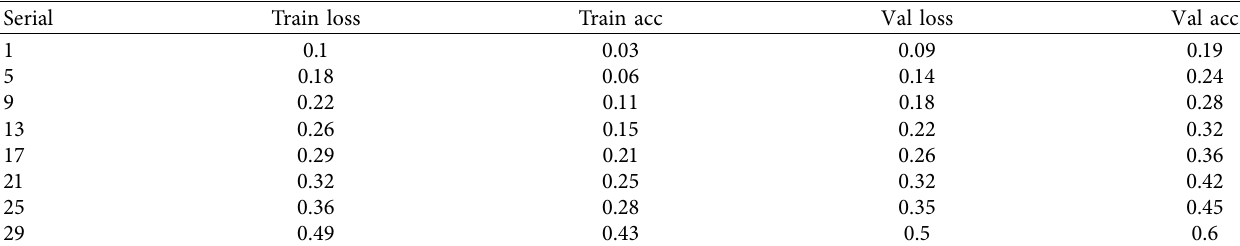
Table 6: ResNet-50 loss and accuracy.